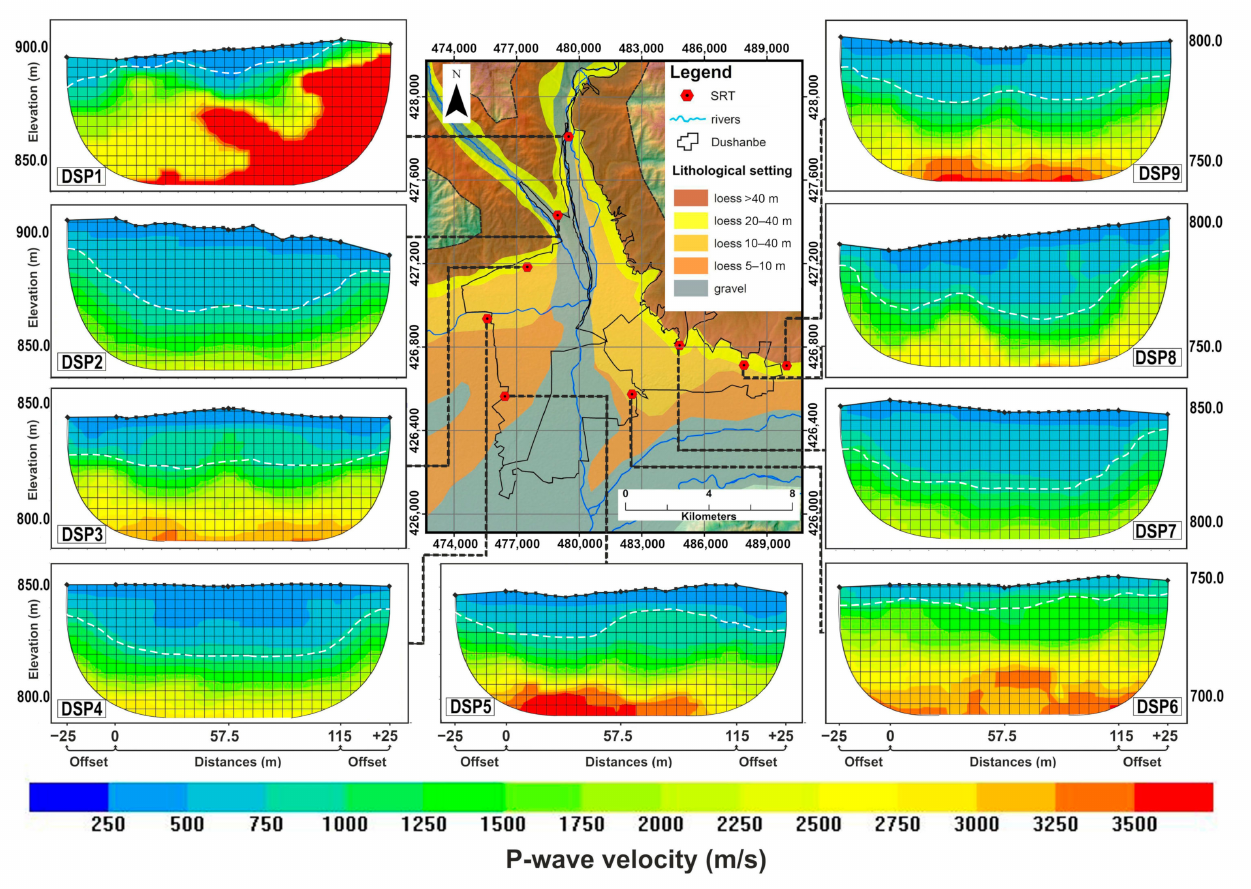
Figure 6. Results of the nine seismic refraction tomography (SRT) profiles, dash white line showed basis of loess layer. The uppermost layer with P-wave velocities <750–1250 m/s corresponds to the second and third terraces’ uppermost loess layers (Figure 6). SRT profiles DSP2, DSP3, and